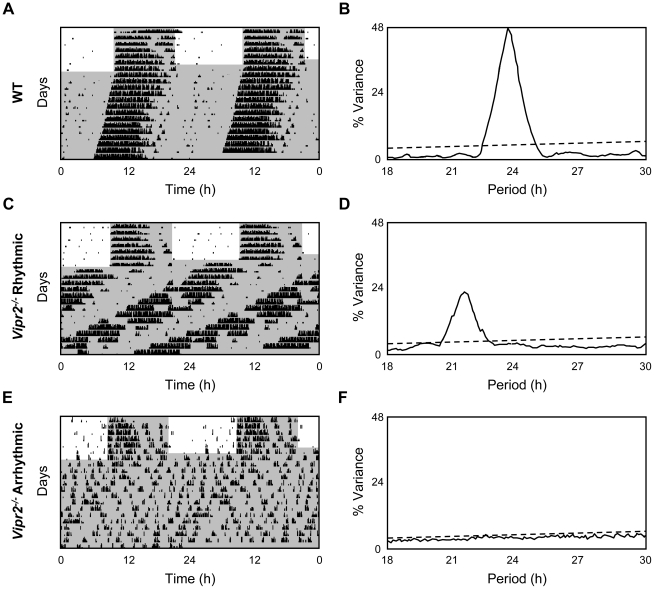
Representative Actograms and Periodograms for Individual WT and Vipr2−/− Mice Expressing the PER2::LUC Reporter.Both WT and Vipr2−/− PER2::LUC-expressing mice synchronize to an LD cycle (A, C, E). WT mice [expressing the PER2::LUC reporter] exhibit a strong, near 24 h, locomotor activity rhythm in DD, evident on the actogram (A) and from the corresponding high power periodogram peak at ∼24 h (B). Activity recordings and periodograms from Vipr2−/− mice expressing the PER2::LUC reporter display a continuum of behavioral phenotypes in DD, from strongly rhythmic with a shortened behavioral period (∼22.5 h; C–D) to arrhythmic (E–F). Actograms are double-plotted, showing 2 days per row; shaded areas on actograms represent darkness. Peridograms depict period (hours; x axis) and strength of the rhythm (%V; y axis). Dashed line indicates p = 0.001.